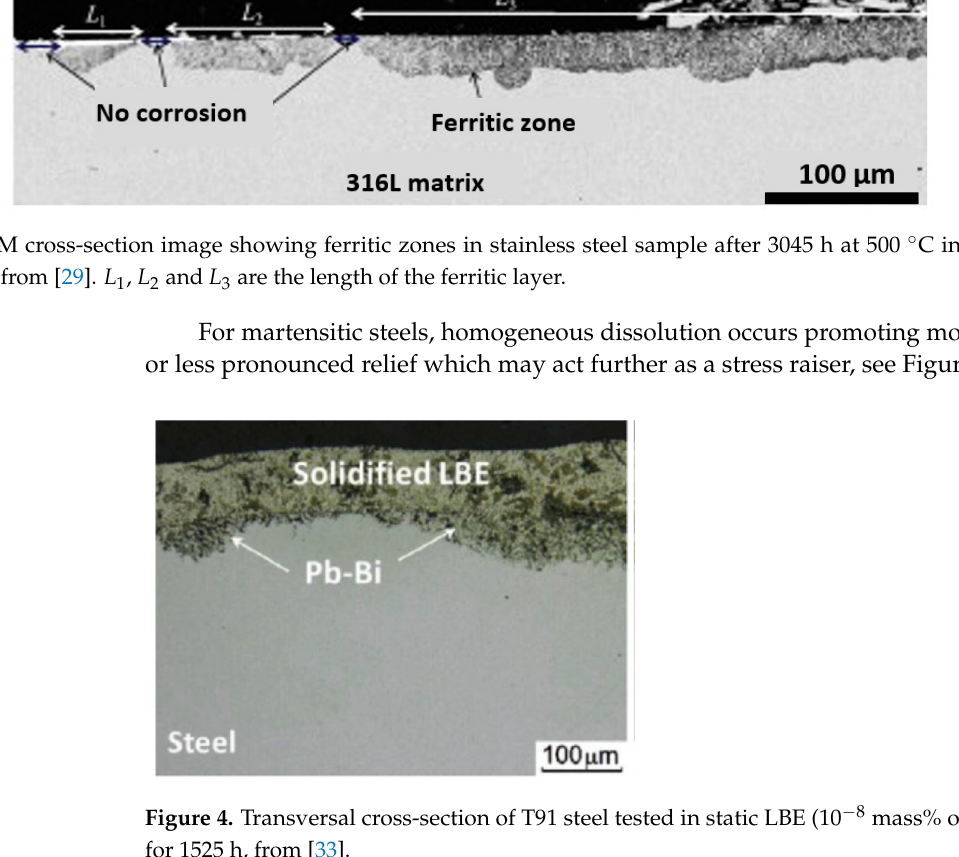
Figure 4. Transversal cross-section of T91 steel tested in static LBE (10 − 8 mass% oxygen) at 550 °C for 1525 h, from [33].